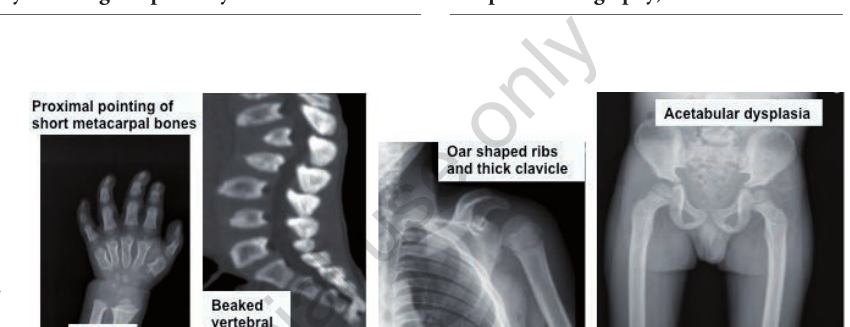
Figure 4. A and B) Progressive coarsening of facial appearance. Same patient with mucopolysaccharidosis type II at 12 and 26 years of age respectively.